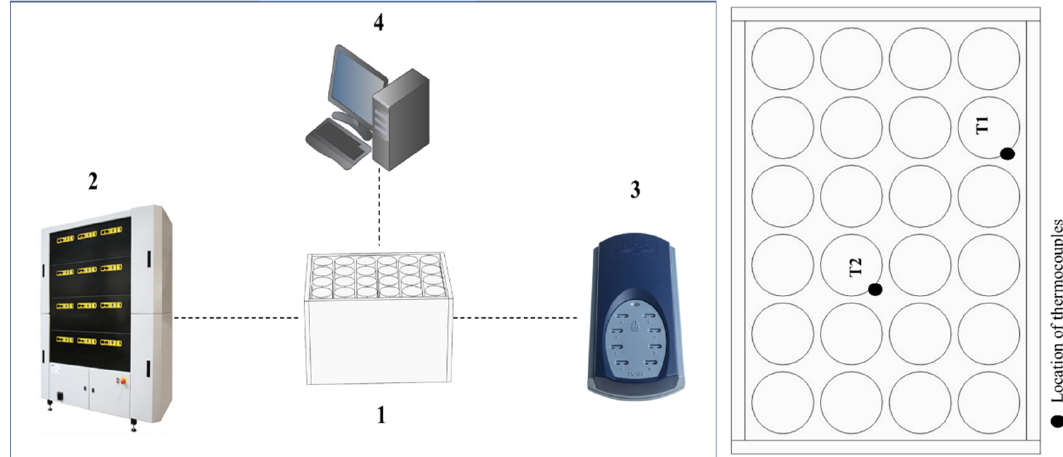
Figure 2. ( left ) The picture of the test setup comprising (1) the battery module, (2) battery tester, (3) data logger, (4) personal computer, ( right ) and the location of the thermocouples.